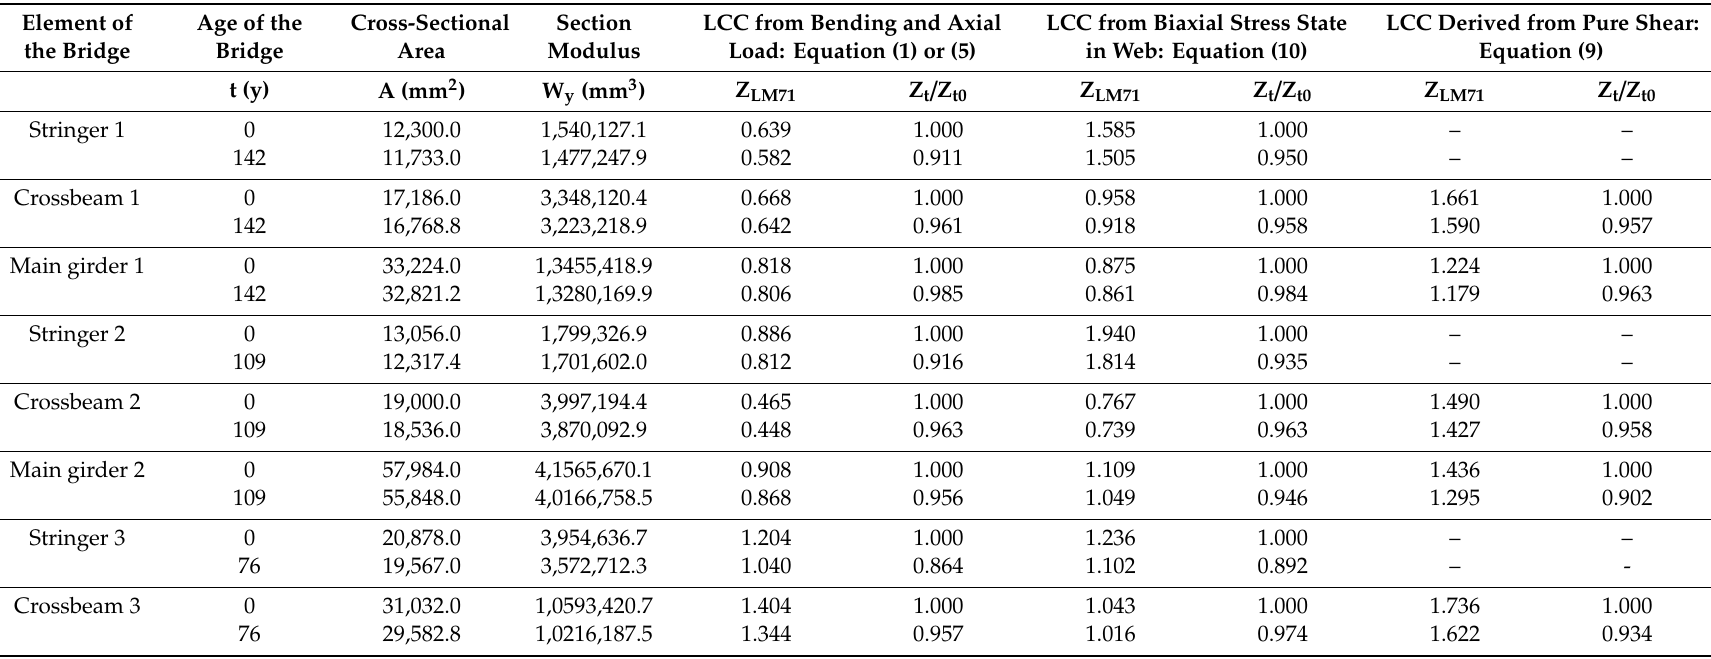
Table 2. Results of the load-carrying capacity (LCC) of chosen